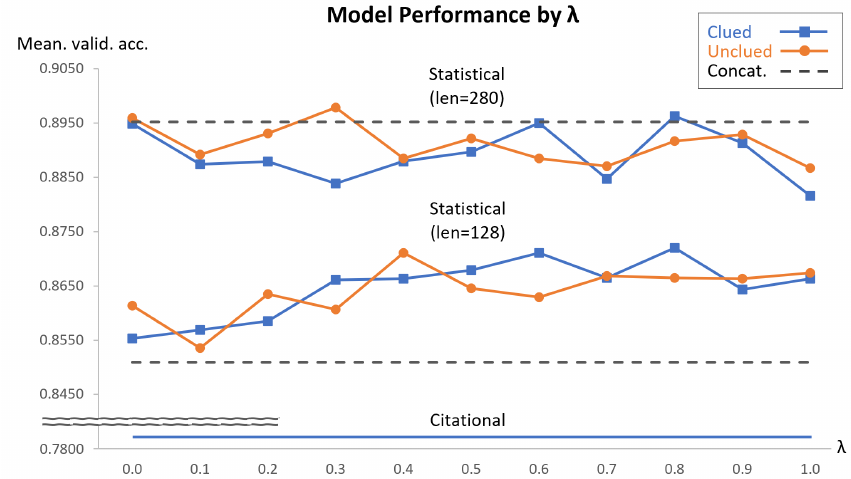
Figure 2. Document classification performance of the three modes. This shows the document classifi- cation performances of the three modes, including the modified BertGCN, the original BertGCN, and the citation-based GCN